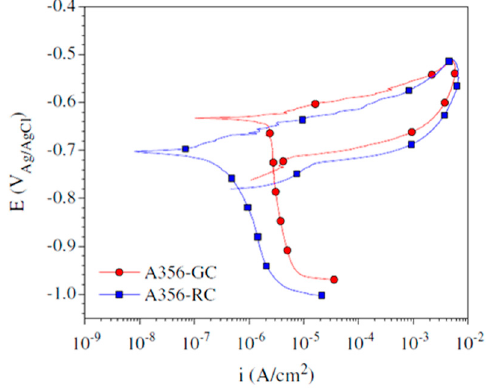
Figure 13. Cathodic polarisation curves of ( a ) gravity cast (GC) and ( b ) SSM (RC) A356 alloy after 1 h immersion in 3.5 wt. % NaCl naturally-aerated solution [113].